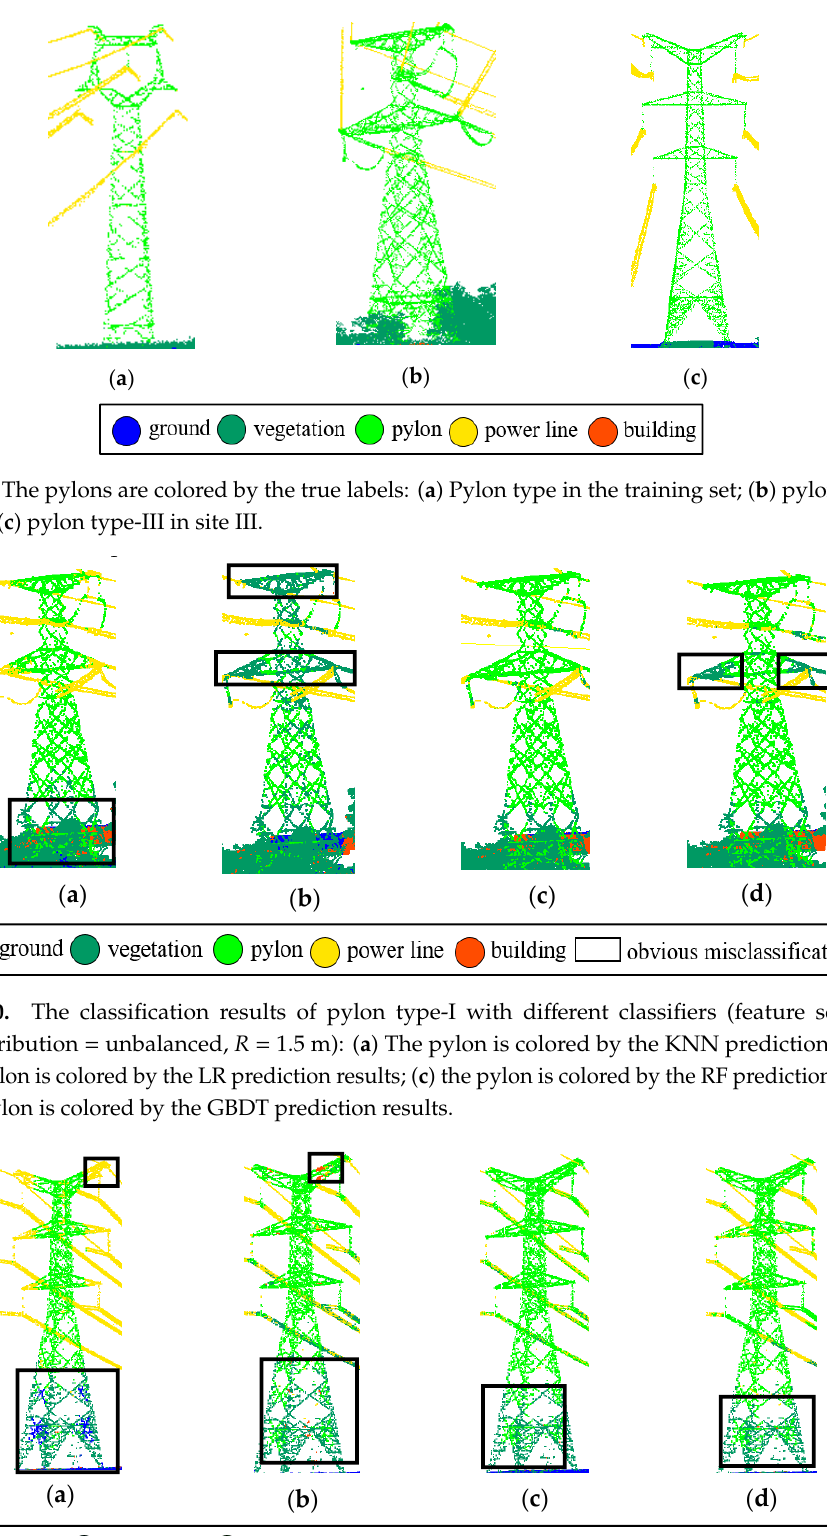
Figure 10. The classification results of pylon type-I with different classifiers (feature set = F 0 , class distribution = unbalanced, r = 1.5 m): ( a ) The pylon is colored by the KNN prediction results; ( b ) the pylon is colored by the LR prediction results; ( c ) the pylon is colored by the RF prediction results; ( d ) the pylon is colored by the GBDT prediction results.